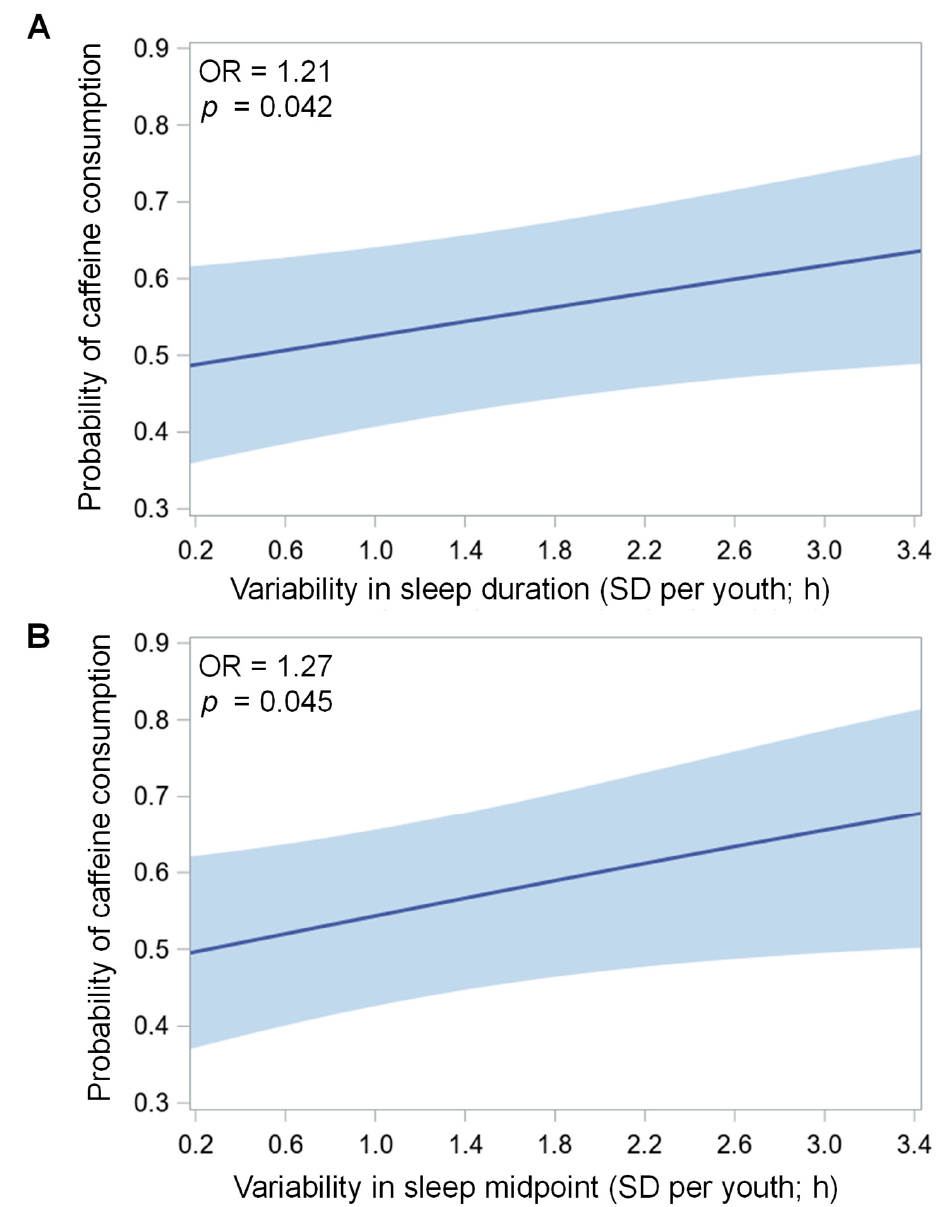
Figure 1. Associations of variability in sleep duration ( A ) and midpoint ( B ) (each in standard deviation, SD hours) per youth with average probability of caffeinated beverage consumption (0 = none; 1 = at least one 8 oz beverage that day), which includes coffee or tea, caffeinated soda, and energy drinks, across monitoring days in two separate mixed models. The mean number of valid actigraphy nights per youth included in present analyses was 5.6 ± 1.4 (range 3–10; interquartile range, IQR 5–7) and the mean number of reports of caffeinated beverage consumption was 5.5 ± 1.4 (range 3–9; IQR 4–7). Both models adjust for mean sleep duration (linear and quadratic, sleep duration x sleep duration) and demographic/household covariates: birth sex, race/ethnicity, household income, and primary caregiver’s education level. Shaded light blue bands depict 95% confidence interval of mean probability of caffeinated beverage consumption per youth predicted from each sleep measure. H, hours; OR, odds ratio; SD, standard